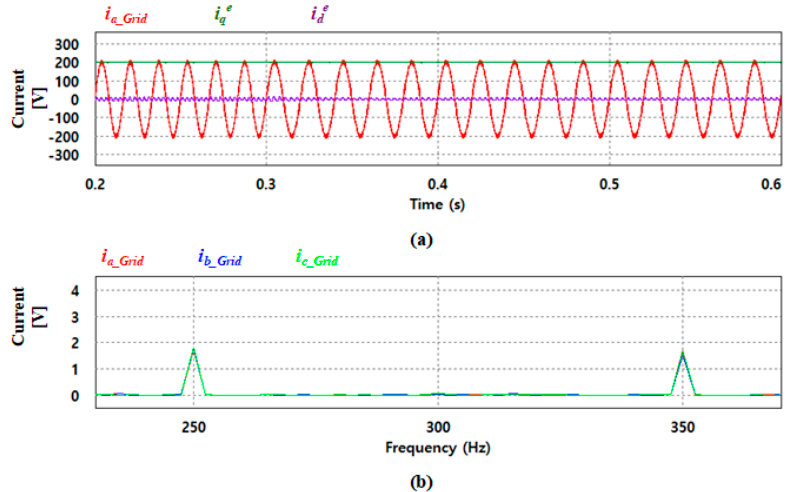
Figure 19. Proposed harmonic compensation method (grid frequency: 60 Hz → 50 Hz): ( a ) three-phase grid voltage, a-phase current, and d-q axis current; ( b ) FFT analysis result of three-phase current.